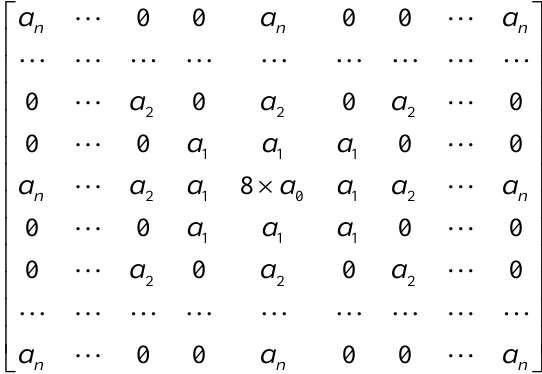
Figure 2. Fractional differential operation direction.